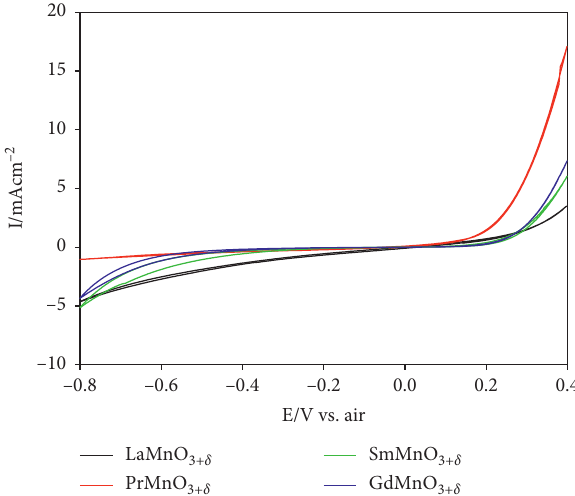
Figure 2: Voltammograms recorded in 10% O 2 in Ar at 200C with Figure 4: The voltammograms recorded on the four manganite- a sweep rate of 1mV/s. The voltammograms show that the ma- based perovskite with different A-site cations in an atmosphere terials are active for both oxygen evolution and oxygen reduction. A with 10% O 2 in Ar at 400 C with a sweep rate of 1mV/s. At this marked difference in the activity is observed as a function of A-site temperature, only little difference is observed in the cathodic re- cation. The most active compounds are the SmMnO 3+ δ and gion. However, in the anodic region, where oxygen is evolved, the GdMnO 3+ δ perovskites. PrMnO 3+ δ perovskite has a much higher activity than the other three perovskites.